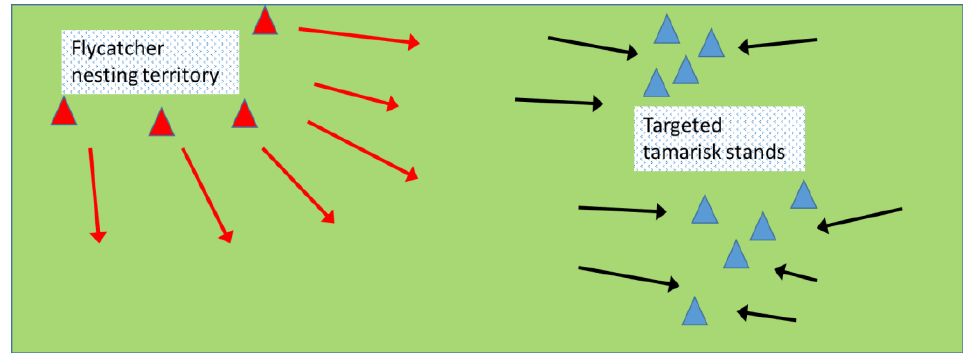
Figure 5. A push-pull semiochemical strategy to repel reproductive adult D. carinulata away from nesting territories of the endangered southwestern willow flycatcher, where tamarisk may be uti- lized [43] and attract them to areas where tamarisk is targeted for removal. The repellent (red triangles) is placed near nesting territories where it diminishes the number of adult beetles colonizing tamarisk shrubs [17]. The D. carinulata pheromone blend (blue triangles) is placed on trees targeted for removal. Beetles are attracted (black arrows) to the pheromone, resulting in elevated D. carinulata populations and accelerated defoliation of the shrubs [23,54]. Targeted areas with blue triangles will be defoliated early in the season while the flycatcher nesting territory will remain green until later, after birds have fledged.